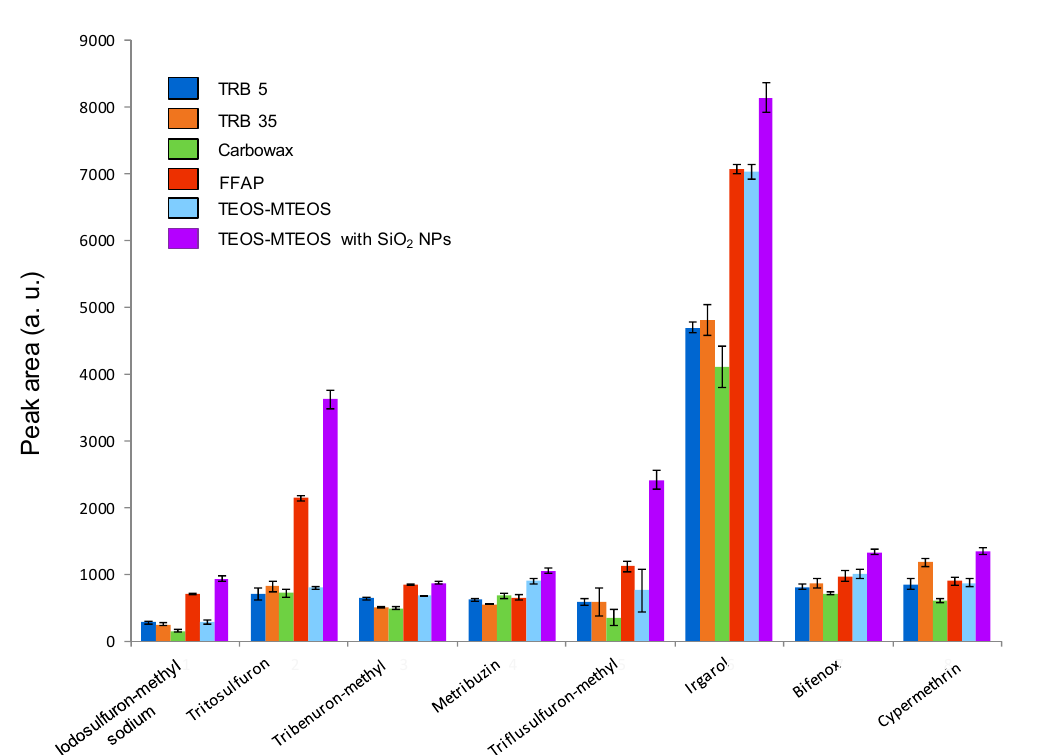
Figure 1. Peak areas obtained with the tested capillary coatings ( n = 3). Concentration of the analytes, 200 µ g/L.